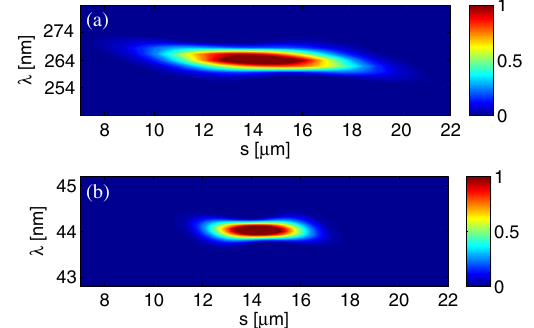
FIG. 12. Wigner distributions of coherent harmonic radiation at fundamental (a) and 6th harmonic (b) of the seed. The FWHM pulse length of the seed laser is 16 fs. The frequency chirp in the seed laser pulse is (cid:6) ¼ 0 : 006 =(cid:1) s 2